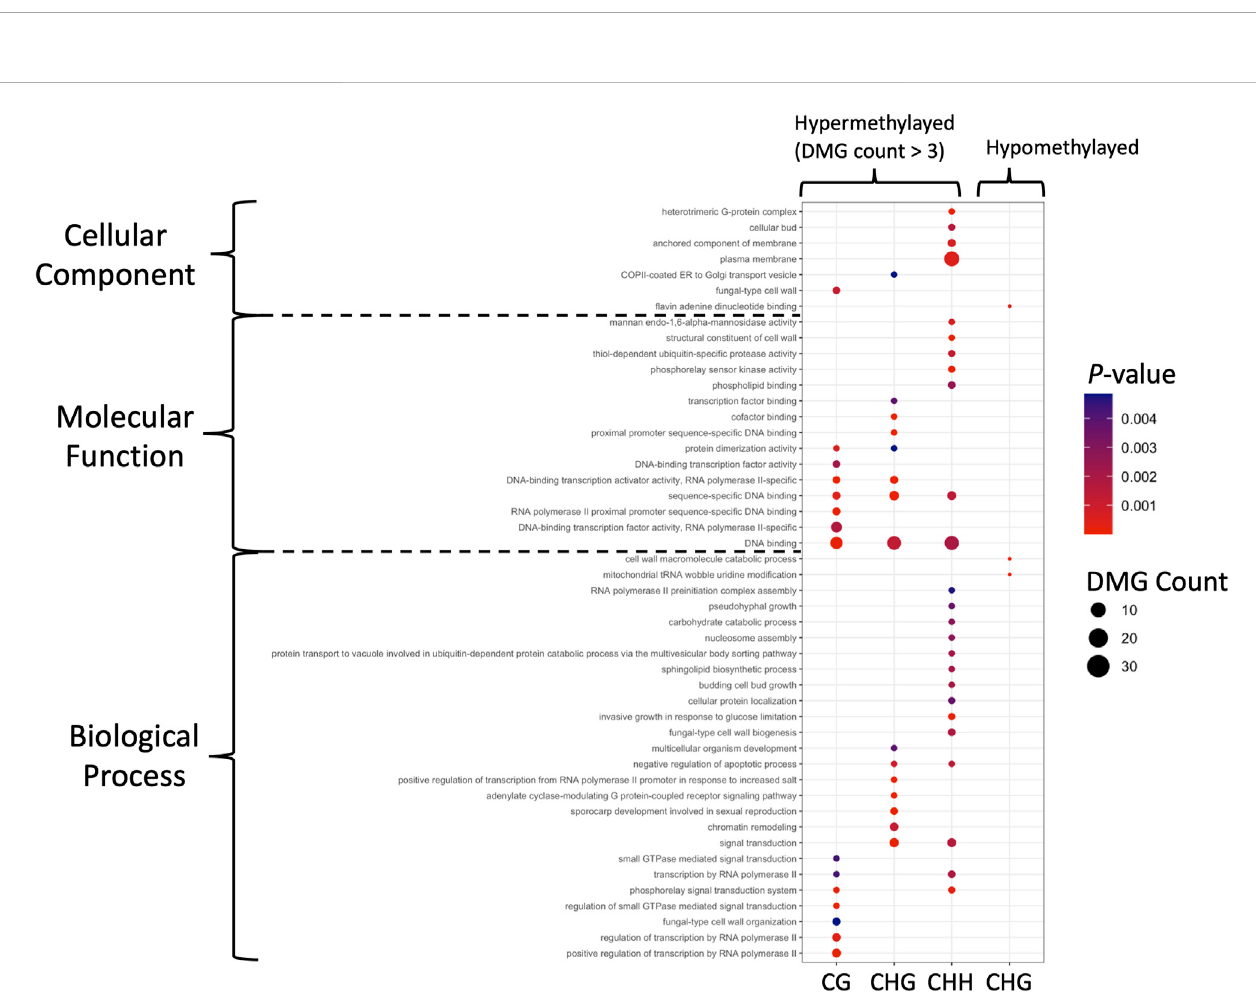
FIGURE 6 GO identi fi cation of the DMGs in DMRs. Hypermethylated and hypomethylated DMGs with p -value < 0.05 are presented as dot plots. Each methylation pattern is indicated at the bottom. Colors indicate the p- values obtained from Fisher ’ s exact test, and the dot sizes are proportional to the number of DMGs involved in the GO